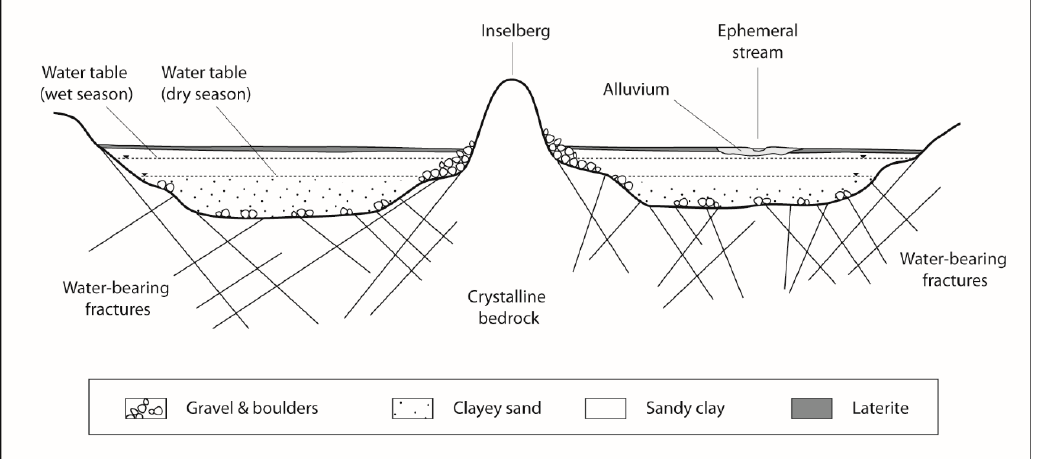
Figure 2. Schematic geological section of the study area.